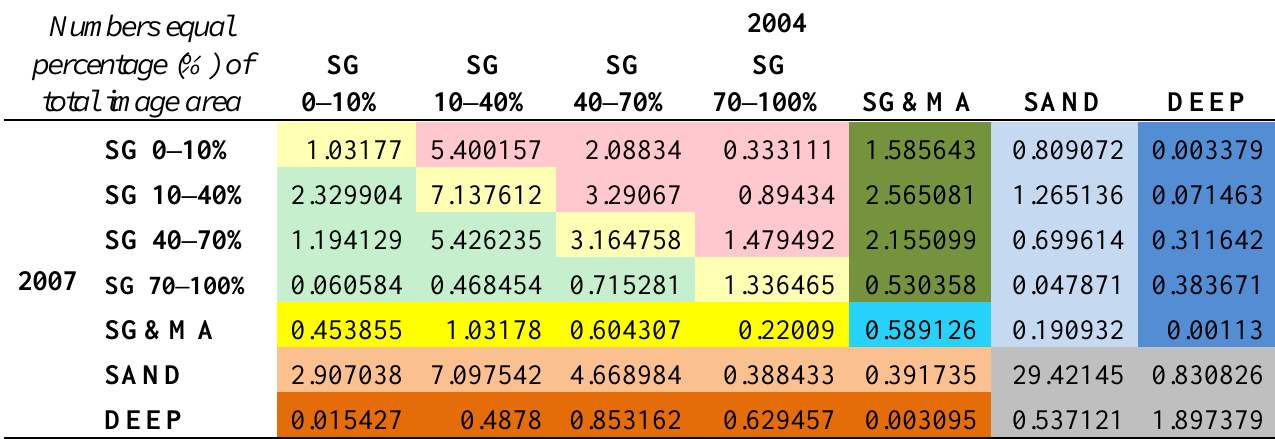
Table 2 . Post classification change matrix quantifying change in cover classes as percentage of total image area, between the 2004 and 2007 seagrass cover maps. Pale yellow = no change in SG cover, light green = SG cover increase, red = SG cover decrease, yellow = SG to SG&MA (macroalgae), dark green = SG&MA to SG, cyan = no change in SG&MA, light blue = sand to SG, light orange = SG to sand, dark blue = deep water to SG, orange = SG to deep water and grey = no change in deep water/sand